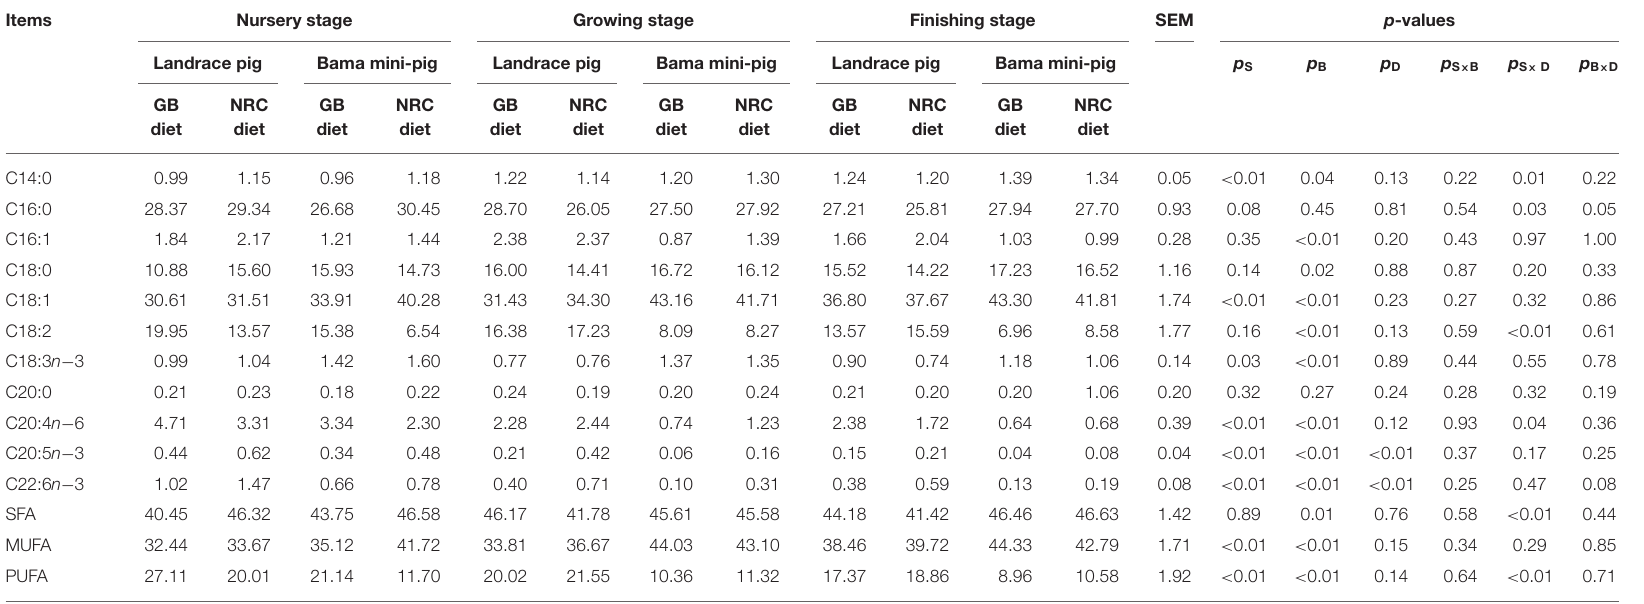
TABLE 4 | Percentages of fatty acids in psoas major muscle of pigs. Items Nursery stage Growing stage Finishing stage SEM p -values Landrace pig Bama mini-pig Landrace